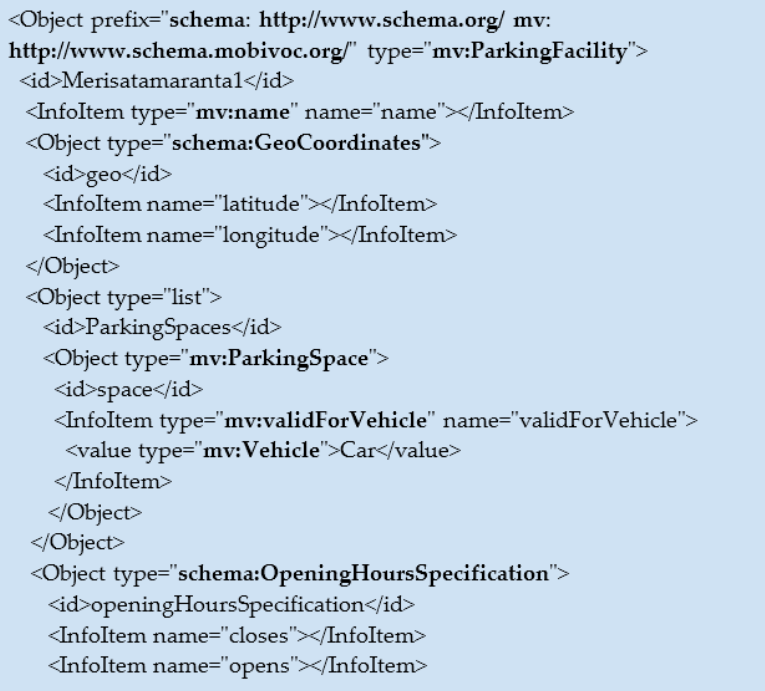
Figure 9. Semantics of O-DF message, ParkingFacility object example.5. Performance Evaluation.